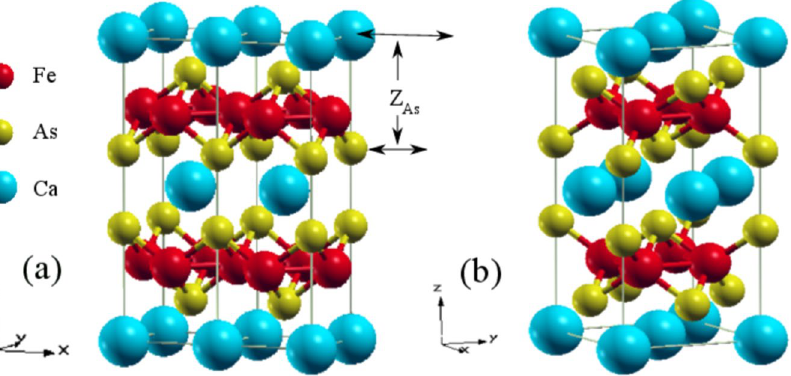
Figure 1. Crystal structure of CaFe 2 As 2 ( a ) Double unit cell of the tetragonal structure and ( b ) single unit cell of the orthorhombic structure.